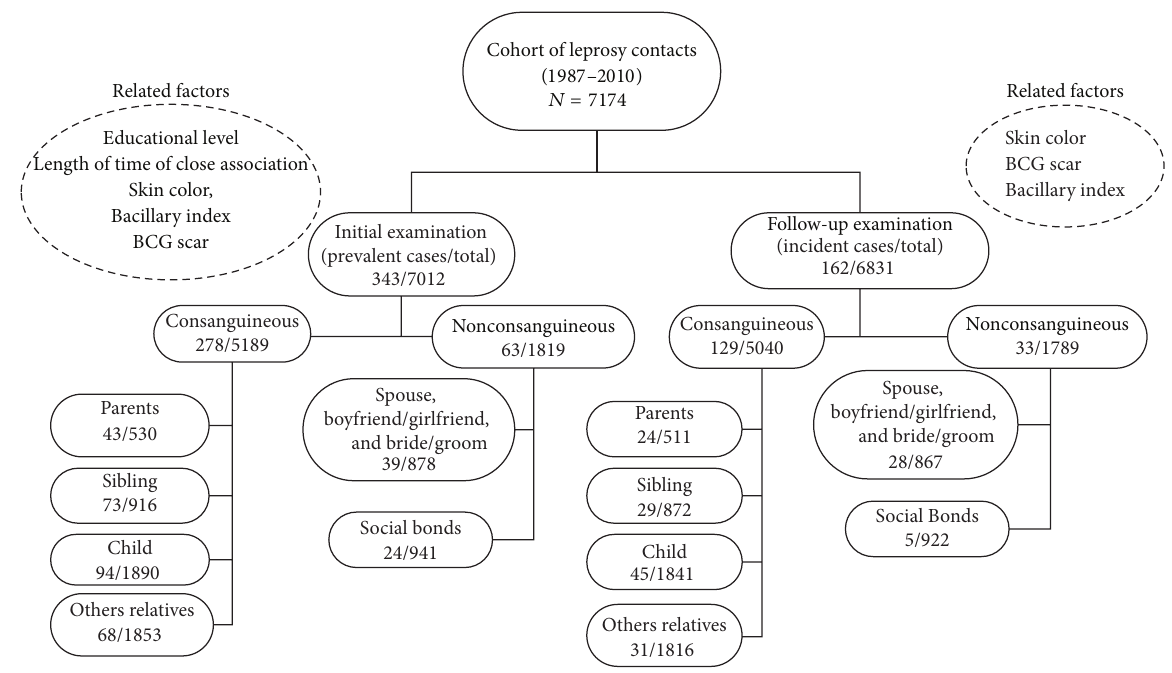
Figure 1: Kinship and leprosy in the contacts of leprosy